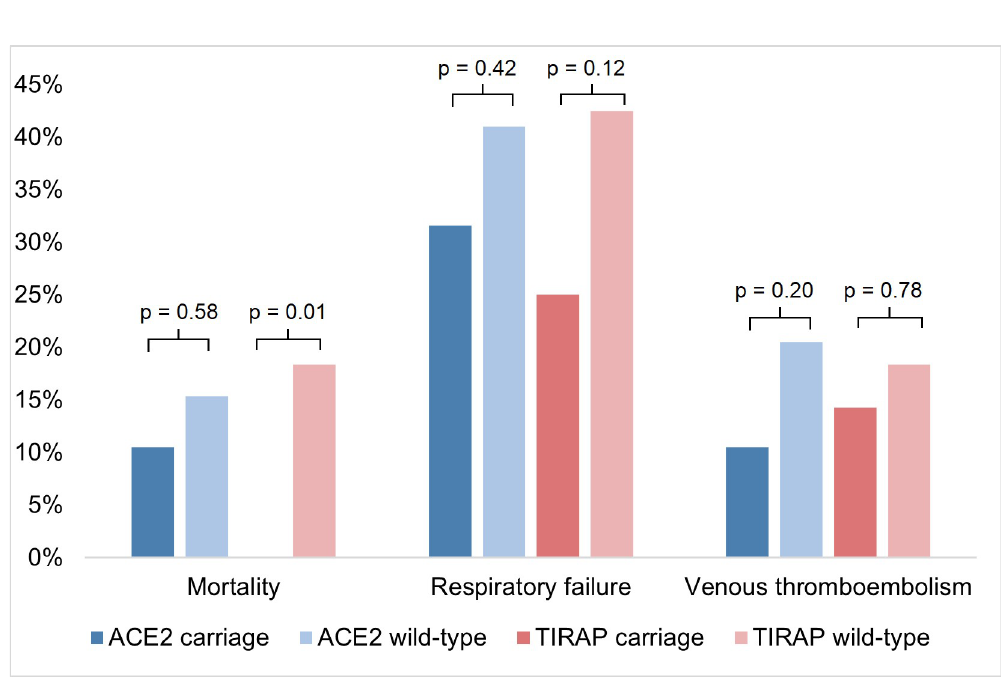
Fig 4. Clinical outcomes stratified per genotype.